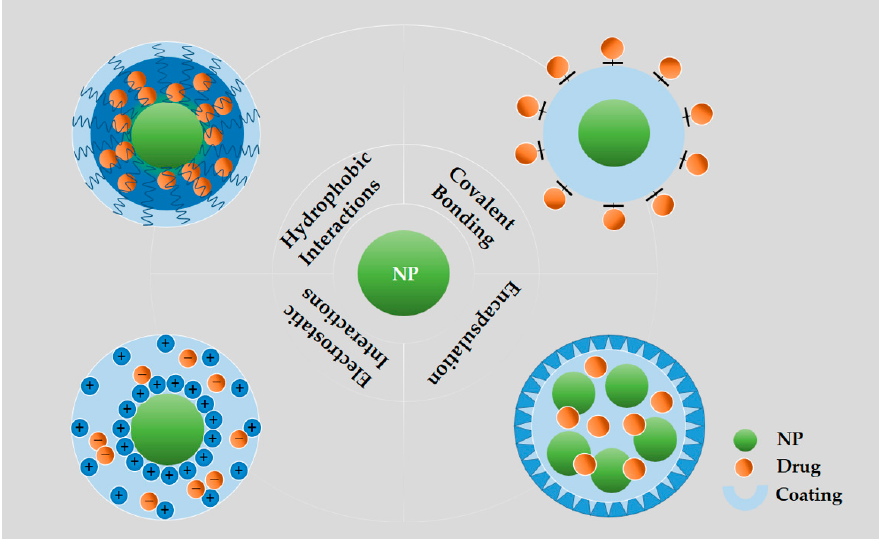
Figure 3. Illustration of various methods of loading/bonding therapeutics into NPs. Covalent bond- ing: Drugs directly to the surfaces of NPs through covalent bonds; Hydrophobic interactions: Partitioning hydrophobic drug molecules in an amphiphilic corona layer; Electrostatic interactions: Loading drugs onto the surfaces of NPs by electrostatic layer-by-layer assembly; Encapsulation: Loading drugs into the hollow NPs.